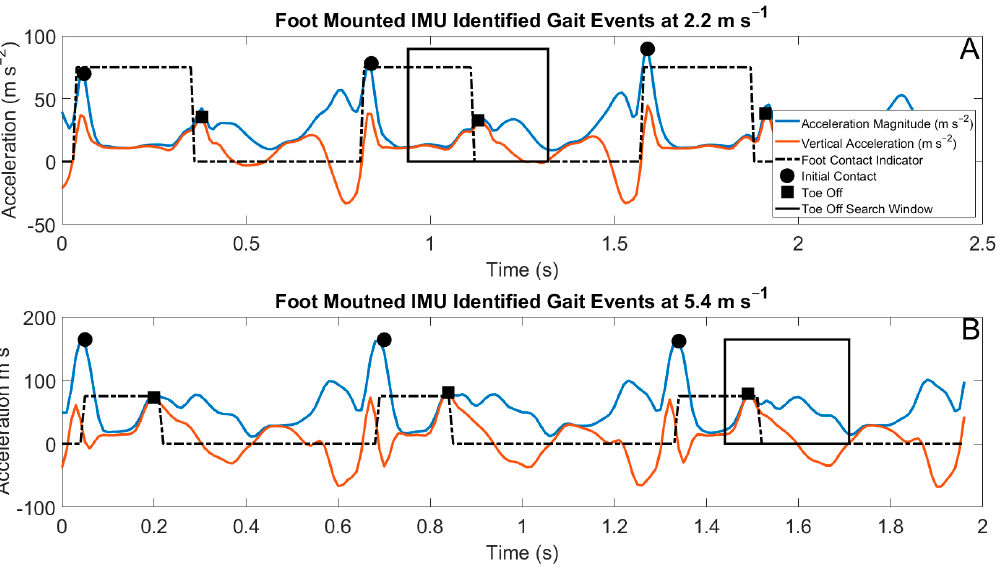
Figure 2. Acceleration waveforms from the IMUs mounted on the right foot (orange and blue waveforms), with superimposed foot contacts (dashed black square waves) identified from the force- measuring insoles. The estimated IC foot is shown in the filled circles, and the estimated TO foot is shown in the filled squares. The search windows used for the identification of TO foot are shown in the solid black rectangles. ( A ) Data from a 2.24 m s − 1 run; ( B ) data from a 5.36 m s − 1